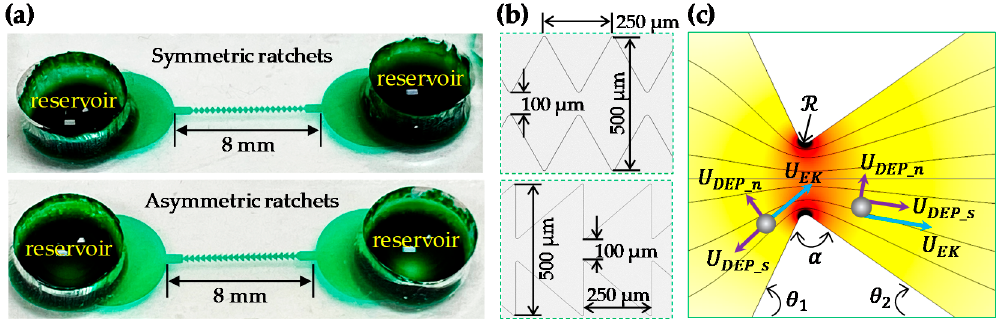
Figure 1. ( a ) Photos of the symmetric (top) and asymmetric (bottom) ratchet microchannels used in the experiment; ( b ) Zoomed-in views of the symmetric (top) and asymmetric (bottom) ratchet structures with their corresponding dimensions highlighted; ( c ) Velocity analysis for a particle traveling towards and away from the ratchet throat, respectively, where the background color shows the electric field contour (the darker, the larger magnitude) and the background lines represent the electric field lines (equivalent to the fluid streamlines).